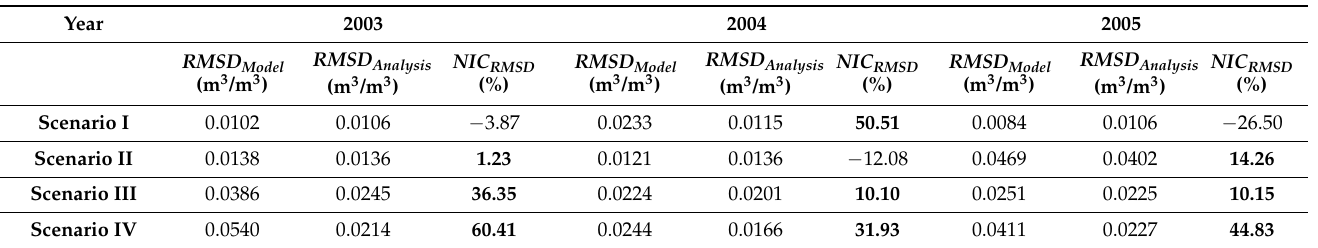
Table 1. NIC RMSD of soil moisture in different assimilation scenarios (I–IV) in 2003, 2004, and 2005. Positive NIC RMSD numbers are marked in bold.